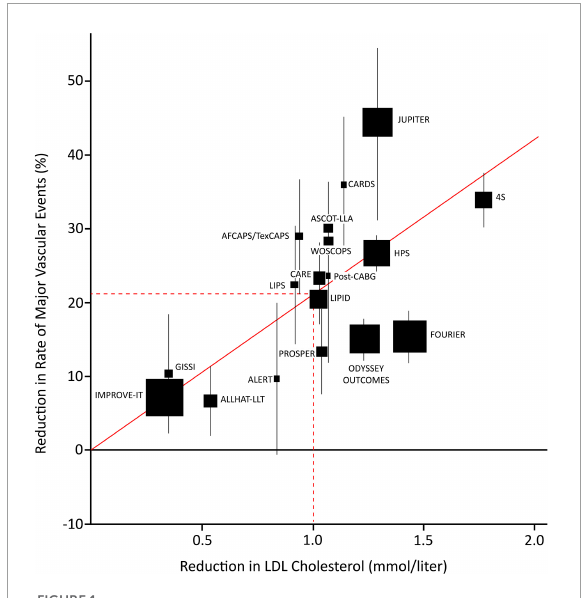
FIGURE1 Plot of statin, ezetimibe, and PCSK9 trials depicting the relationship between mean LDL-cholesterol (LDL-C) reduction and the proportional reduction of major vascular events (MVE) at one year (MVE: composite of death from coronary heart disease, myocardial infarction, stroke, or revascularization more than 30 days after randomization). Squares represent single trials, the size of the squares represent the number of endpoints in the study. The vertical lines represent one standard error (SE). The regression line represents the event rate reduction per mmol/l LDL-C reduction. AFCAPS/TexCAPS, Air Force/Texas